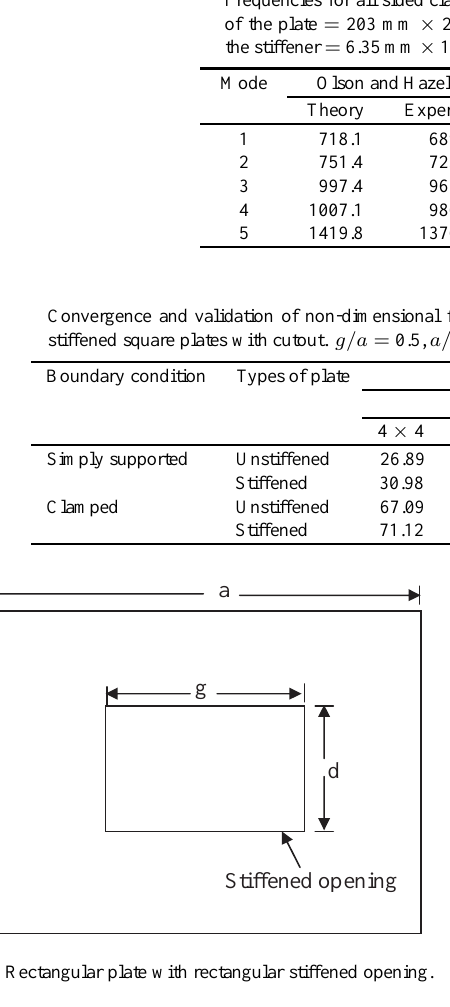
Table 4 Frequencies for all sided clamped plate with central stiffener. Size